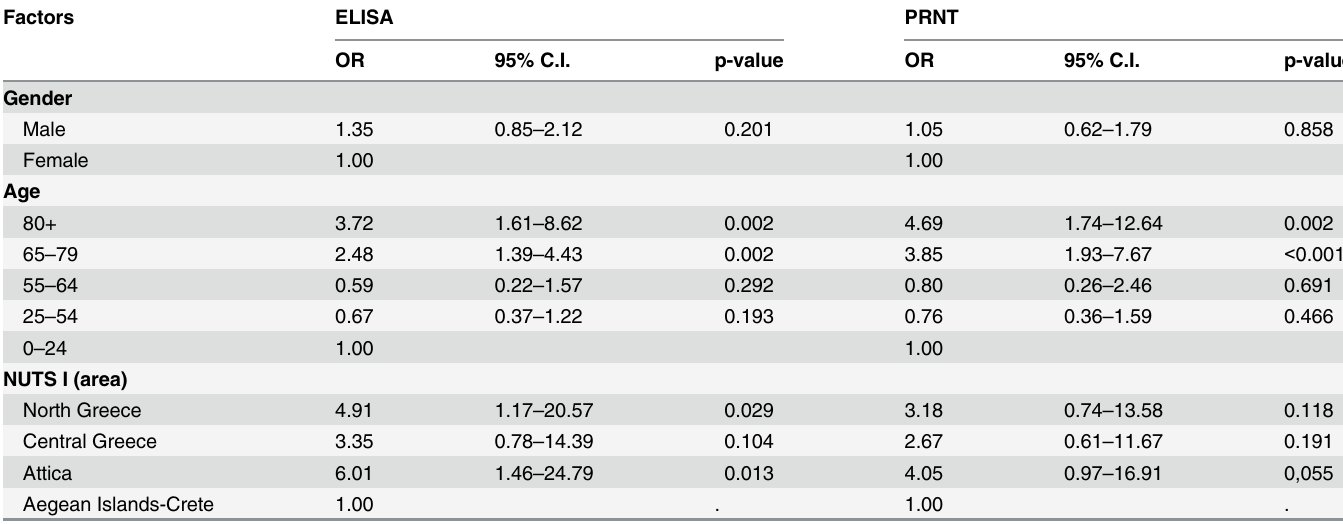
Table 3. Results of the logistic regression model used for the assessment of gender, age and NUTS I-level area of residence on WNV seropositivity.